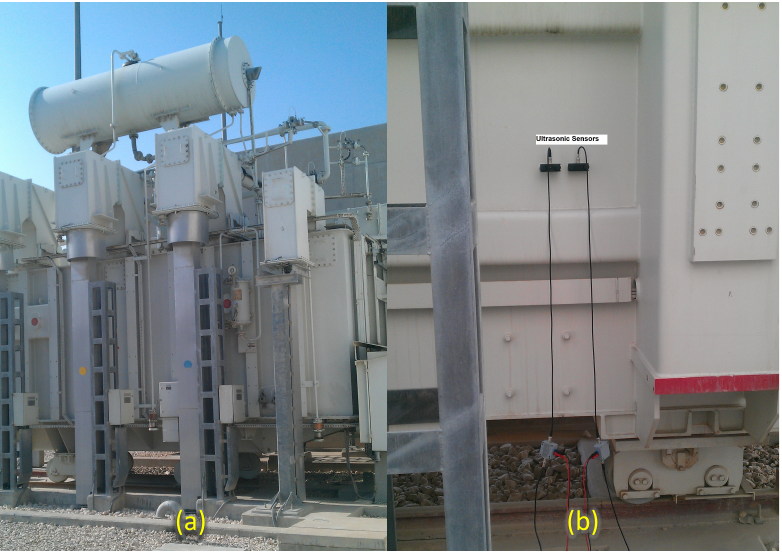
Figure 9. ( a ) A photo of a power transformer, ( b ) acoustic sensors installed on the tank of a